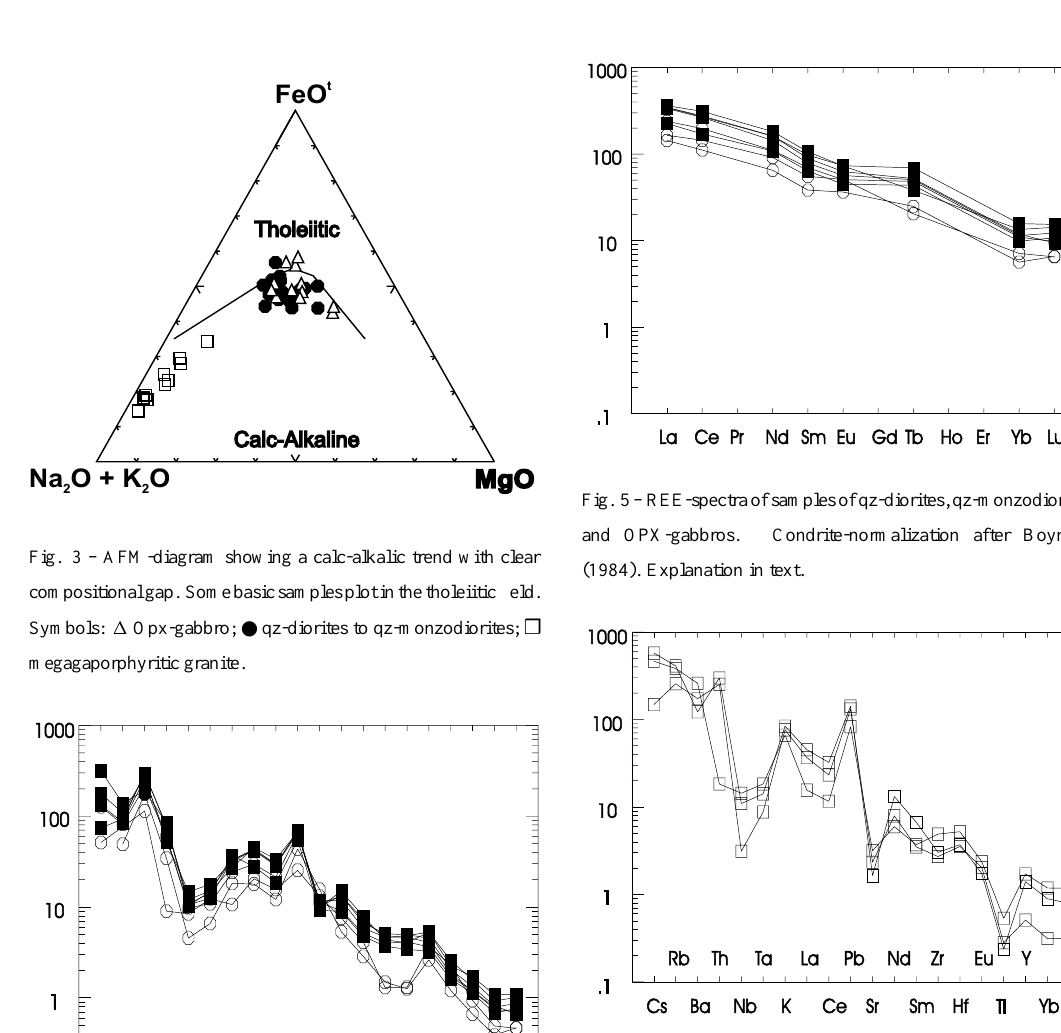
Fig. 6 – Spidergram of compatible and incompatible elements of the megaporphyritic granite. N-MORB-normalization after Sun and McDonough (1989). Explanation in